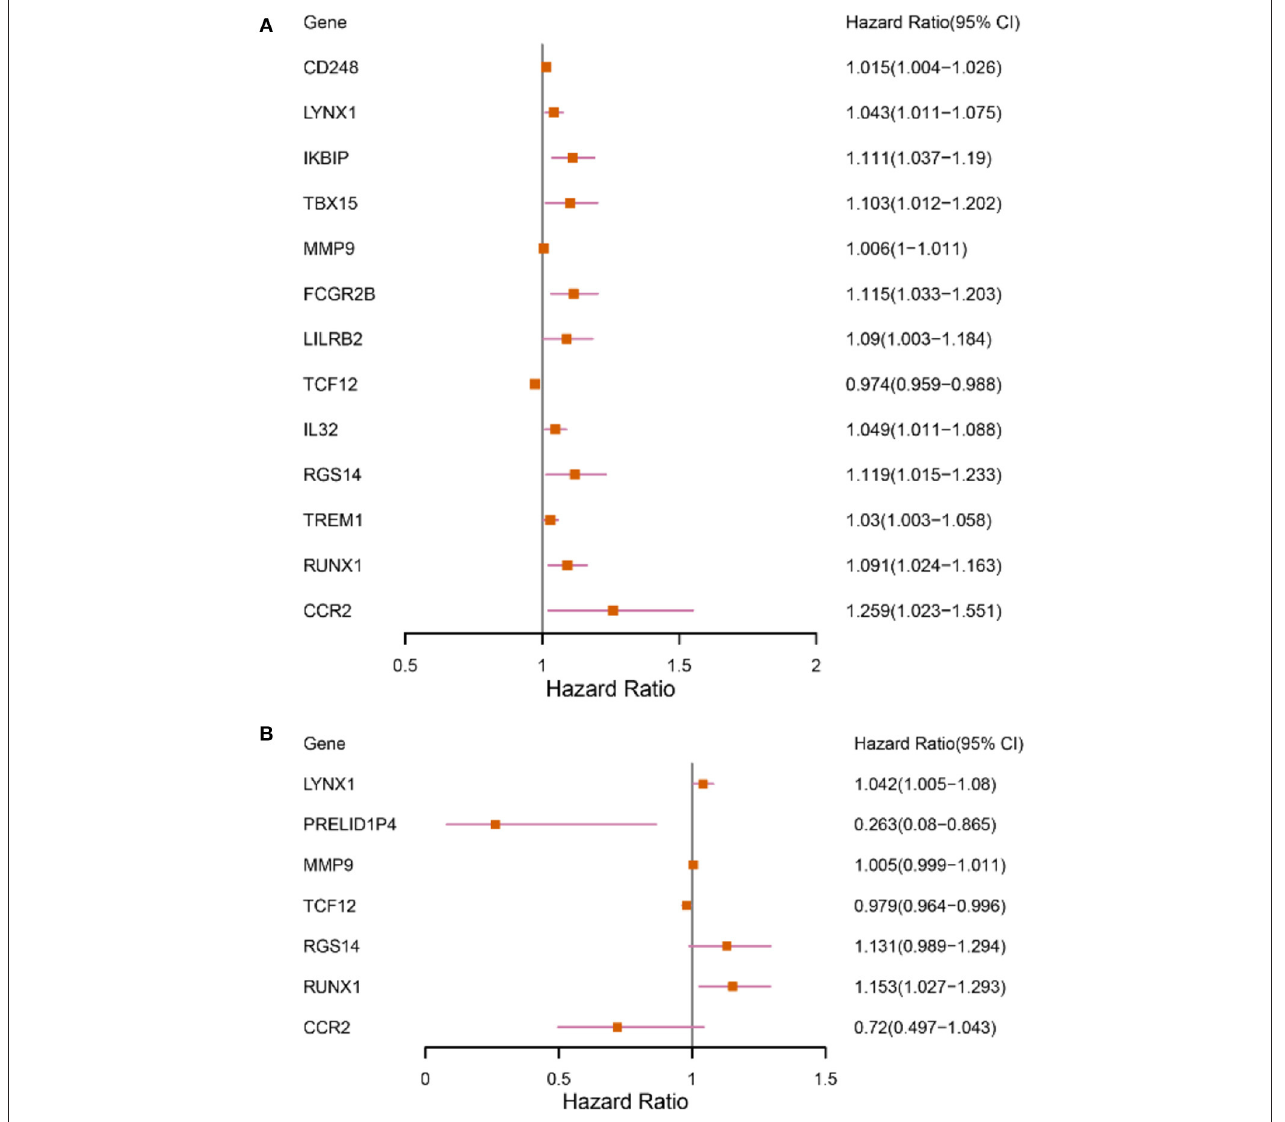
FIGURE 3 | Forest plots depicting the results of univariate and multivariate Cox analyses. (A) The results of 13 DEIRGs were screened out by the univariate Cox analysis (We removed two of the genes with a large confidence interval). (B) The results of 7 prognostic DEIRGs were screened out by following multivariate Cox